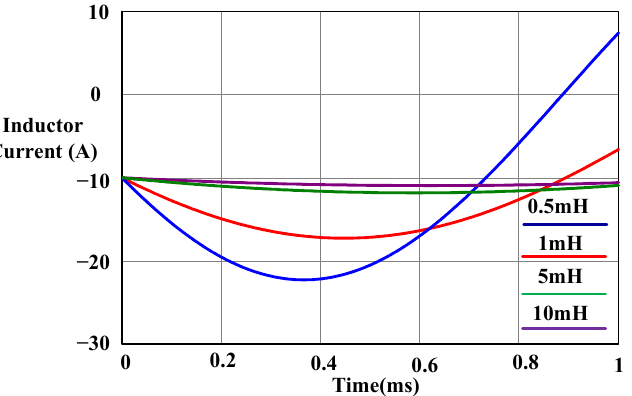
Figure 12. Maximum current under different levels of inductance when S 3 is short-circuited.